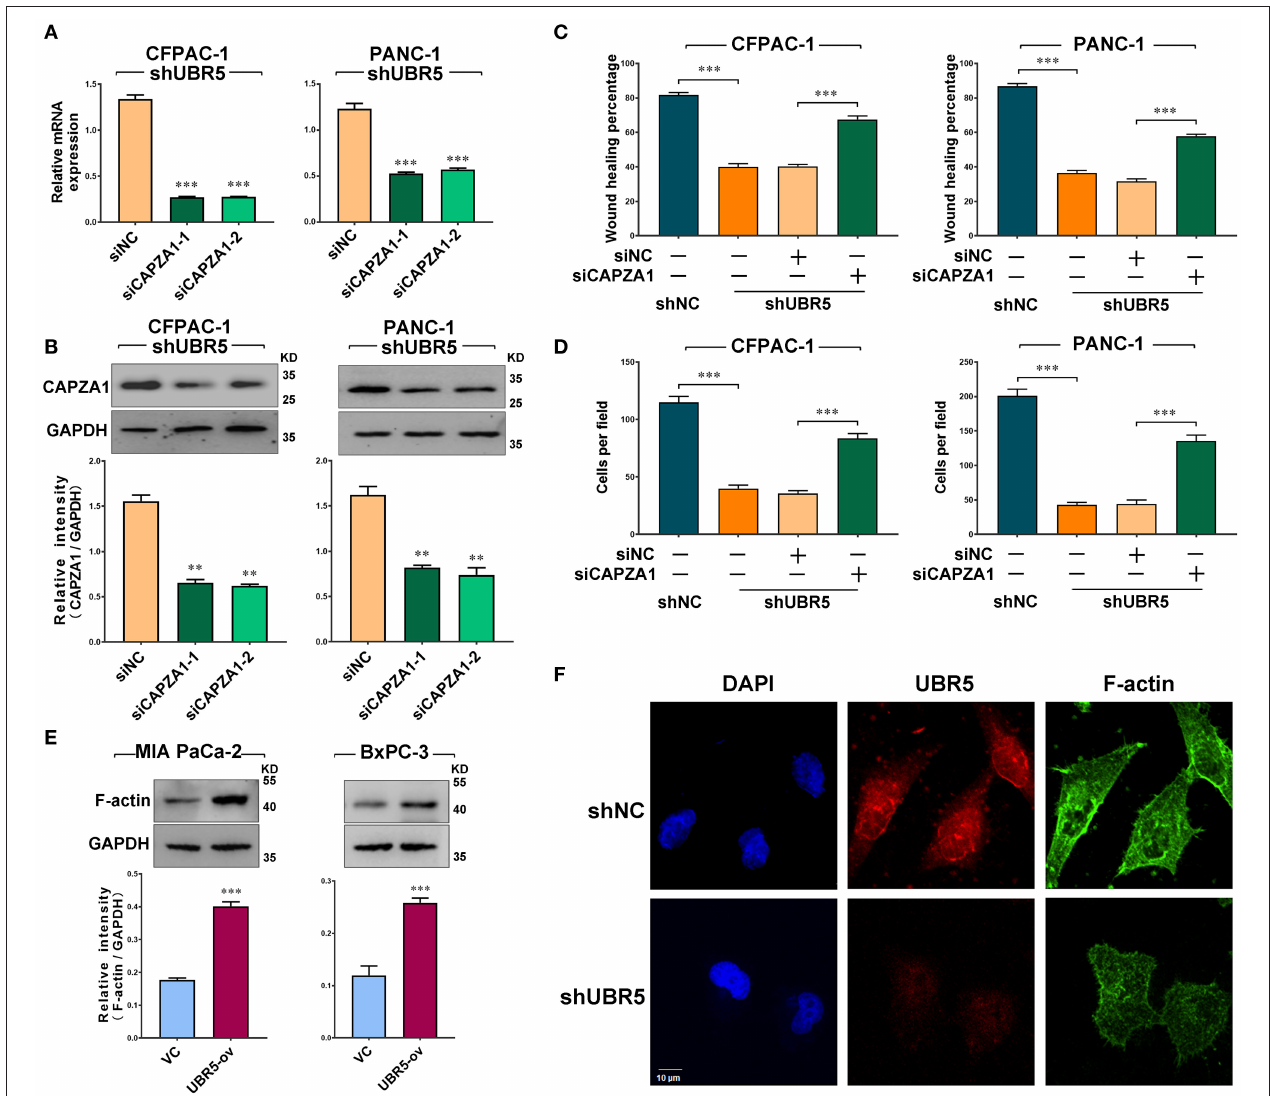
FIGURE 4 | UBR5 promotes pancreatic cancer migration and invasion via CAPZA1-mediated F-actin remodeling. (A) CAPZA1 mRNA expression in CFPAC-1 and PANC-1cells infected with shUBR5. (B) Western blot analysis of CAPZA1 protein levels in CFPAC-1 and PANC-1 cells infected with shUBR5. (C) Wound healing assays in CFPAC-1 and PANC-1 cells transfected with shNC, shUBR5, shUBR5 and siNC, shUBR5 and siCAPZA1. (D) Invasion assays in CFPAC-1 and PANC-1 cells transfected with shNC, shUBR5, shUBR5 and siNC, shUBR5 and siCAPZA1 respectively. (E) F-actin protein levels in MIA PaCa-2 and BxPC-3 cells overexpressing UBR5. (F) Immunofluorescence staining of F-actin and UBR5 in CFPAC-1 cells transfected with shNC or shUBR5. Scale bar = 10 µ m. Data represents mean ± SEM (n = 3 independent biological repeats unless otherwise indicated). ** P < 0.01, *** P <